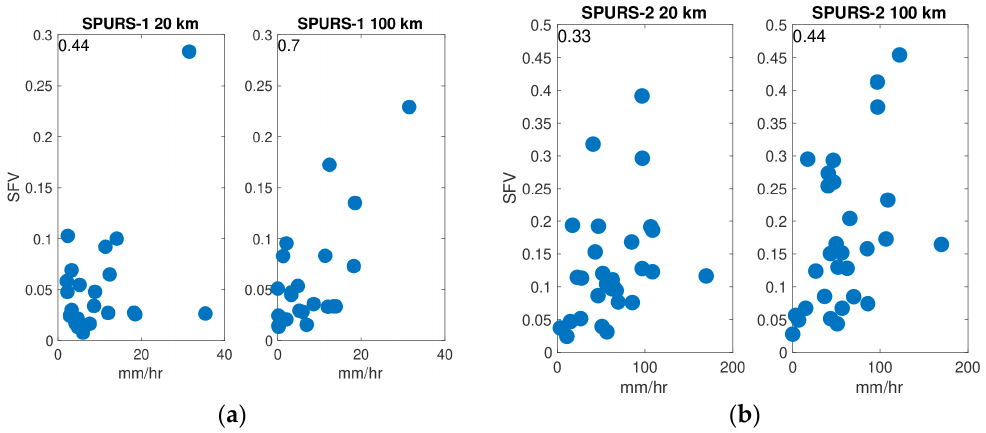
Figure 6. SPURS SFV vs. maximum rain rate measured at the central mooring when this value exceeds 2 mm/hr. Maximum rain rate was determined over the same weekly time intervals as the SFV. Correlation values are shown at the top left of each panel. All are significant at the 95% level, except for SPURS-1 at 20 km which is significant at the 90% level. Left panels: 20 km footprint size. Right panels: 100 km footprint size. ( a ) SPURS-1. ( b ) SPURS-2. Note vertical axes are not consistent between the panels.